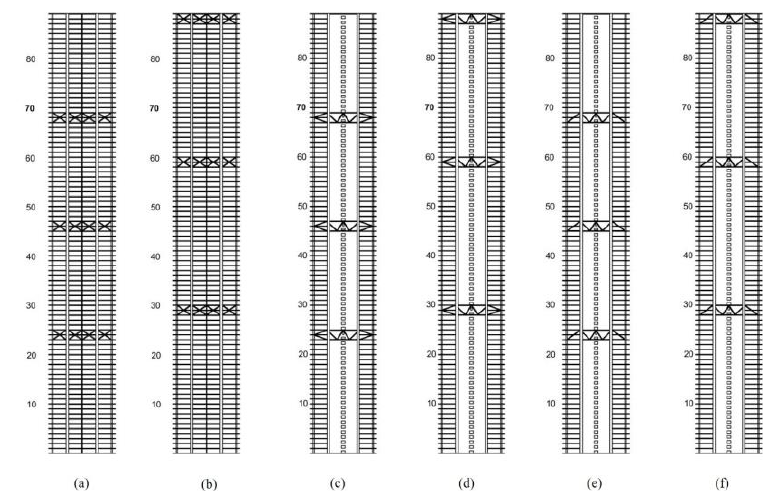
Fig. 2. Standard response spectrum of TSC 2007 and TSC 2017.